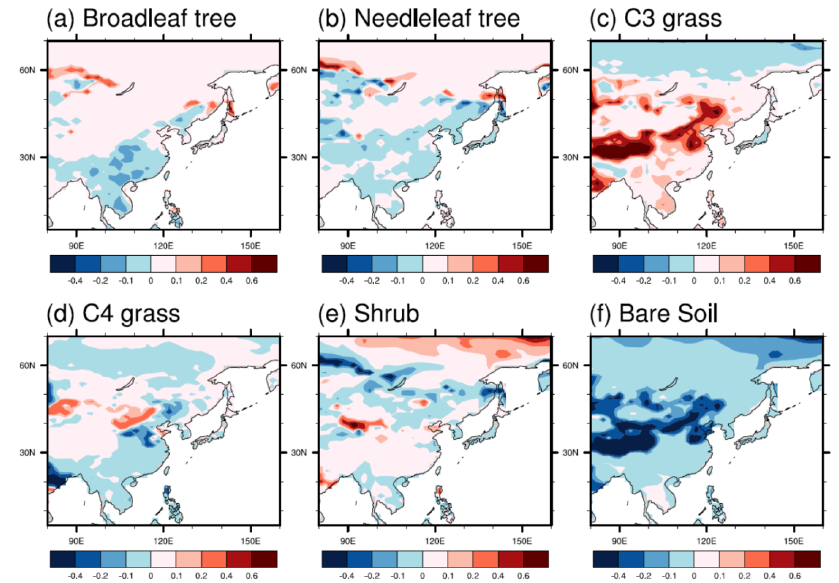
Figure 11. Changes in fractions in land cover between ca. 2100 and present-day as simulated by HadGEM2-ES in the Fifth Coupled Model Intercomparison Project (CMIP5) Representative Concentration Pathway (RCP) 8.5 scenario and applied in AE present and AEts future time slice experiments.